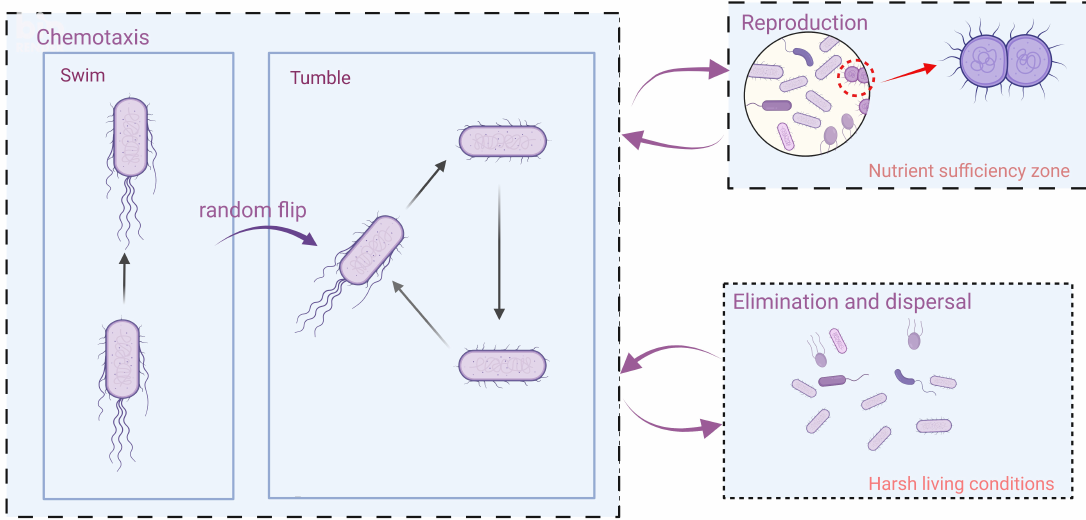
Figure 4. Swimming, tumbling, chemotaxis, reproduction, and elimination and dispersal behavior of E. coli